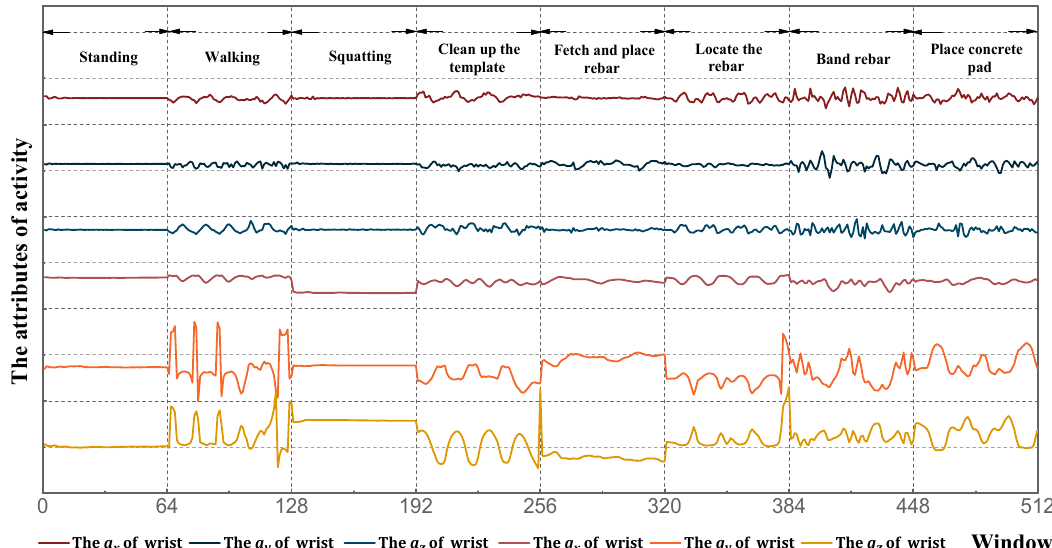
Figure 6. Initial waveform of wrist.